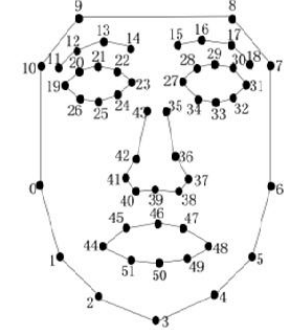
Fig. 3 52 feature points according to FAP parameters Compared to the method of integrating all the classifiers, we can find that the proposed method